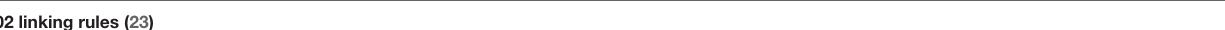
TABLE 2 | Evolution of ICF linking rules developed by Cieza et al.